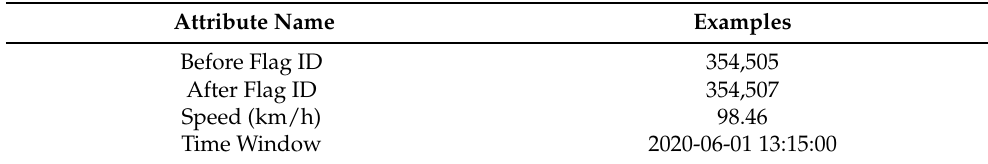
Table 2. Expressway section speed data attribute